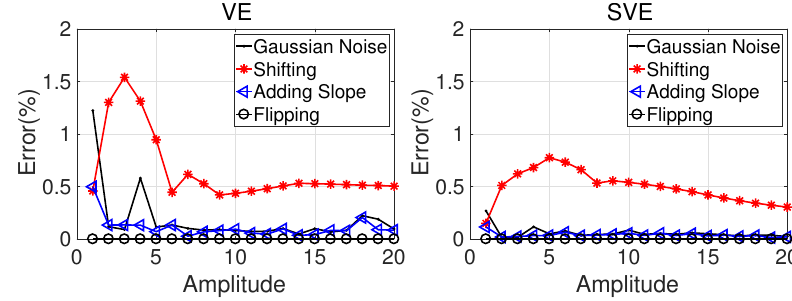
Figure 15. Error caused by synthetic